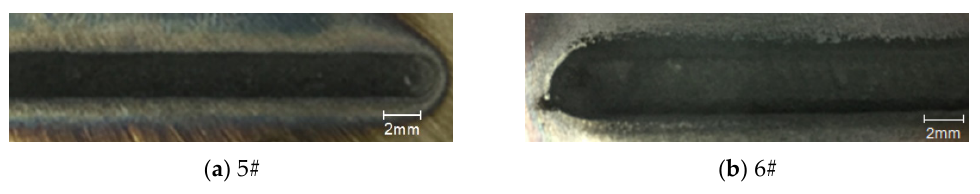
Figure 3. Geometrical morphology of cladding layer.